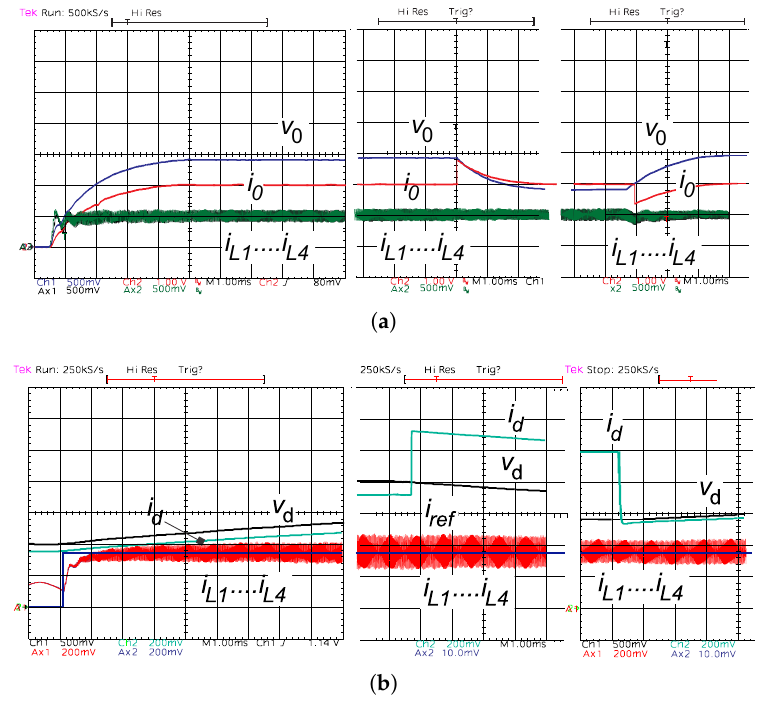
Figure 16. Experimental results, current control, with CR and PI compensator: ( a ) buck mode; x -axis, 1 ms/div, y -axis, V 0 , 100 V/div (blue curve); i 0 10 A/div (red curve), i L 1 to i L 4 5 A/div; ( b ) boost mode, x -axis, 1 ms/div, y -axis, V d 100 V/div (black curve), i d 2 A/div (green curve), i ref 2 A/div (blue curve) i L 1 to i L 4 2